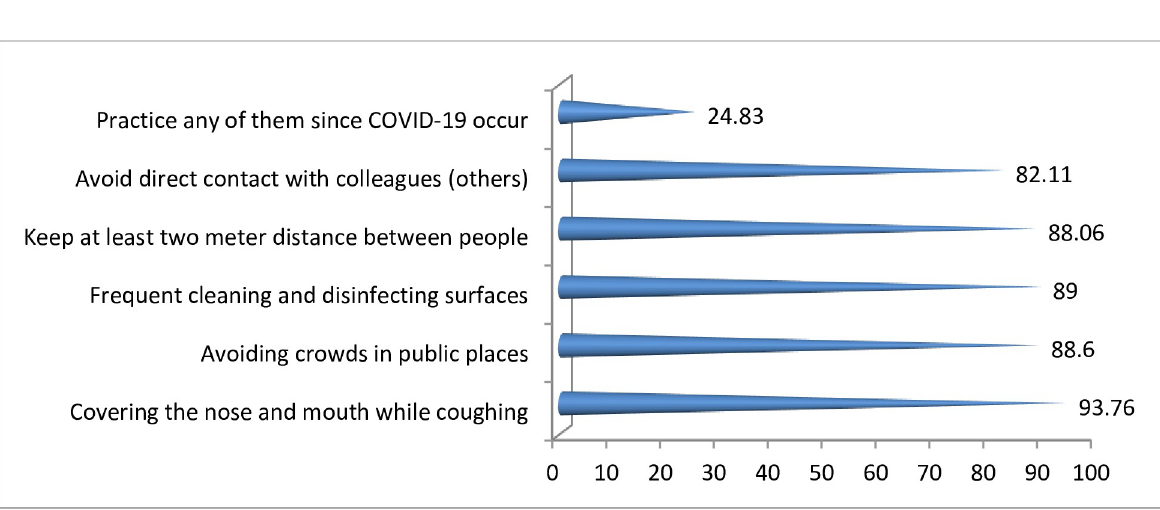
PLOS ONE | https://doi.org/10.1371/journal.pone.0257373 October 20,